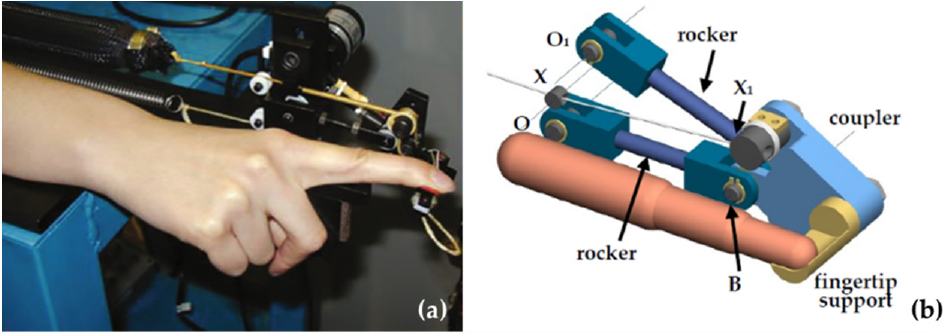
Figure 14. A picture ( a ) and a sketch ( b ) of the haptic finger device